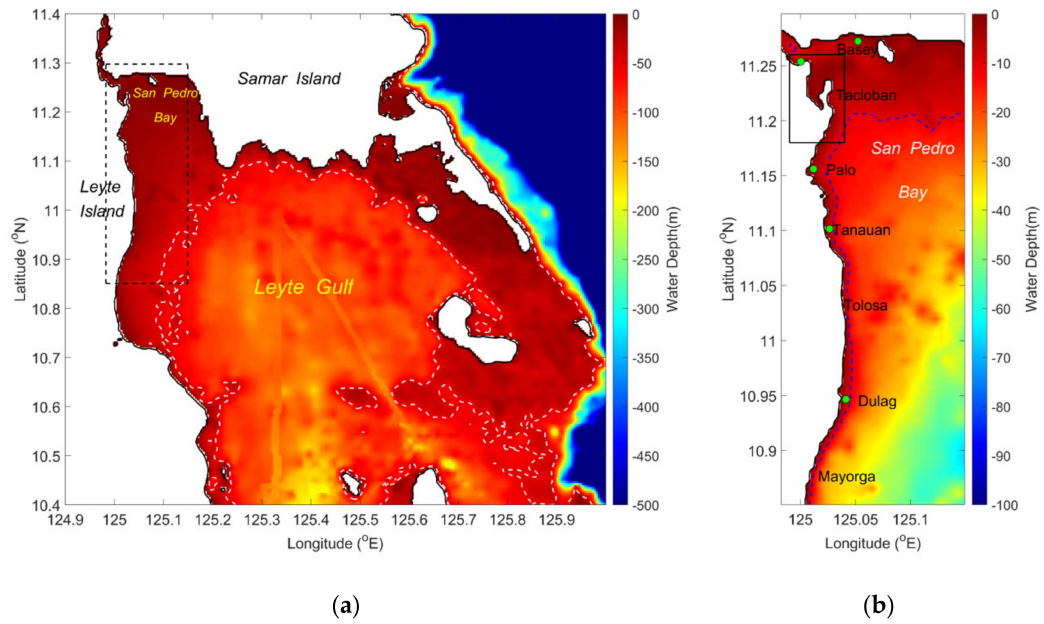
Figure 9. Computational domains of the three-layer nested grids in Leyte Gulf and San Pedro Bay. ( a ) Domain D01 with Domain D02. The color shading indicates the water depths in m. The dashed black line indicates Domain D02. The dashed white line indicates the 50-m water-depth contour. ( b ) Domain D02 with Domain D03. The color shading indicates the water depths in m. The solid black line indicates Domain D03. The dashed blue line indicates the 10-m water-depth contour. The green circles show the numerical gauge locations (see Table 3). Table 2. Nested-grid computational domains, grid sizes, and time steps for calculating storm surges